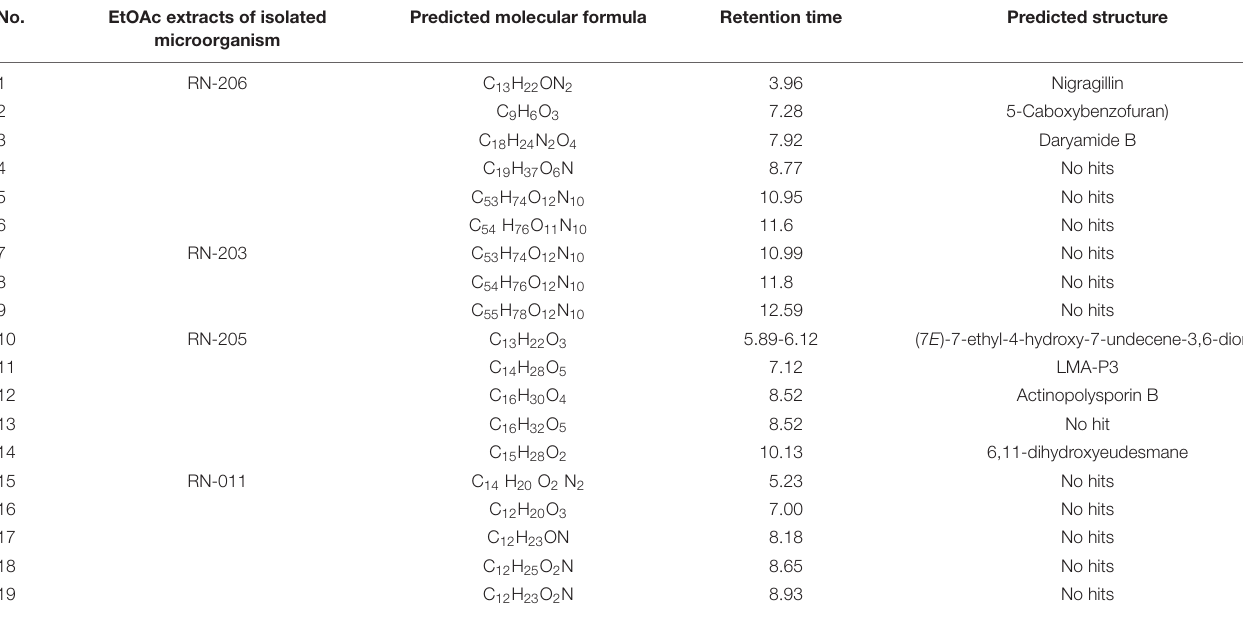
TABLE 2 | Results of LC-HRESIMS analysis for the selected microorganisms EtOAc extracts. No.